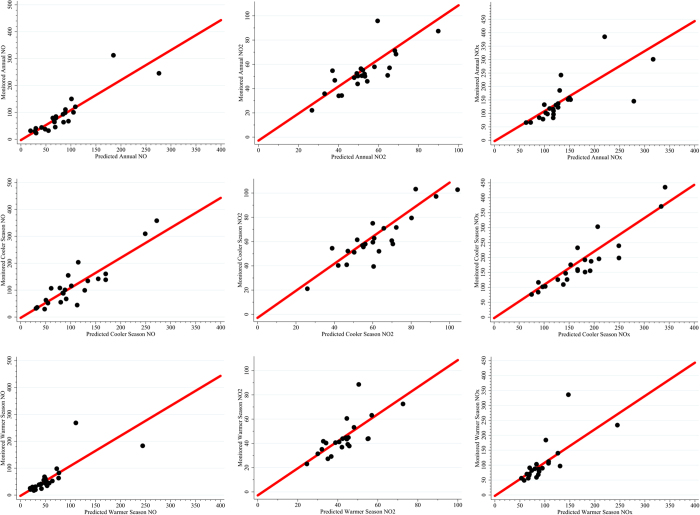
Observed versus predicted concentrations (ppb) for annual, cooler and warmer seasons of NO, NO2, and NOX in Tehran, Iran.The red line is the 1:1 linear prediction. The figures are generated using STATA 13 (STATA Corp., TX, USA, http://www.stata.com/).